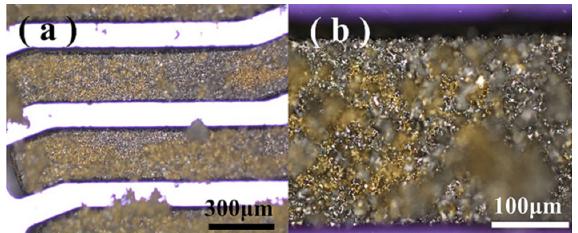
Figure 5. ( a ) Upper and ( b ) lower surfaces of the coil obtained by sintering the pre-alloyed powder after surface cleaning.